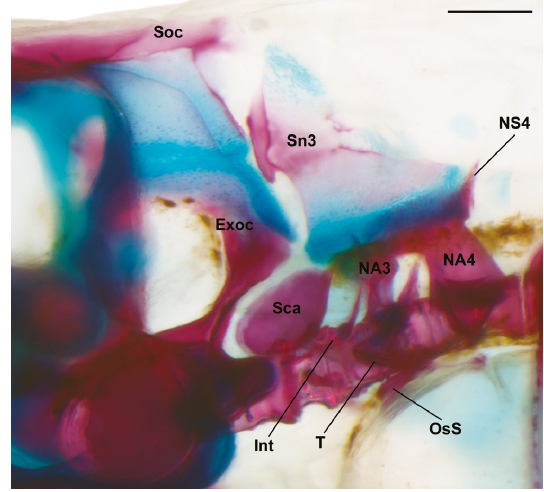
FIGURE 5 | Priocharax britzi , paratype, MZUSP 125823, 12.9 mm SL, c&s; Weberian apparatus in lateral view. Exoc = exoccipital; Int = intercalarium; NA3 – 4 = neural arches 3 – 4; NS4 = neural spine 4; OsS = os suspensorium; Sca = scaphium; Sn3 = supraneural 3; Soc = supraoccipital; T = tripus. Scale bar = 0.2